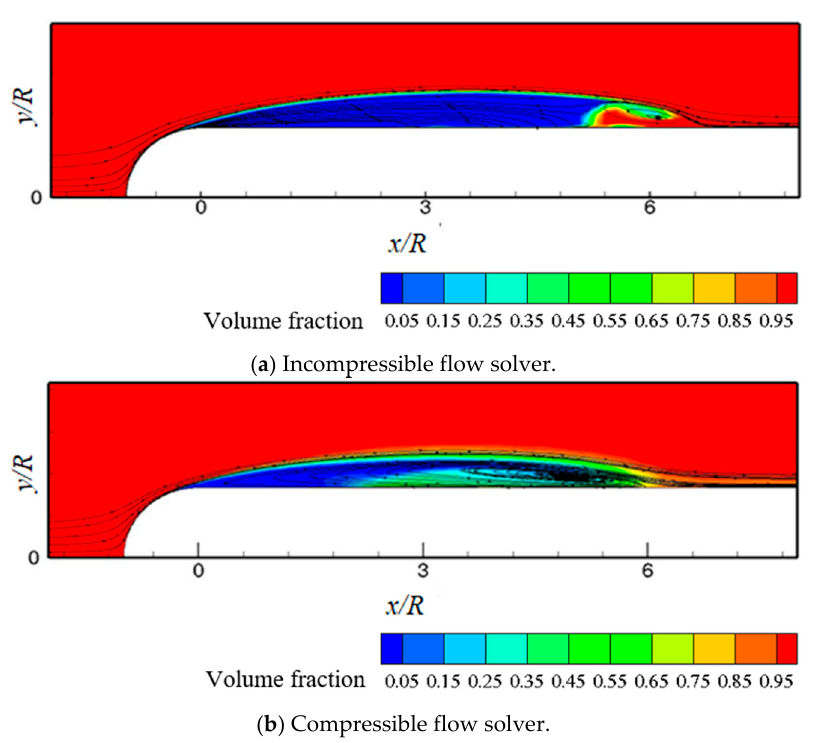
Figure 2. Cavitating flow around a hemispherical head-form body at 𝜎 = 0.2 .